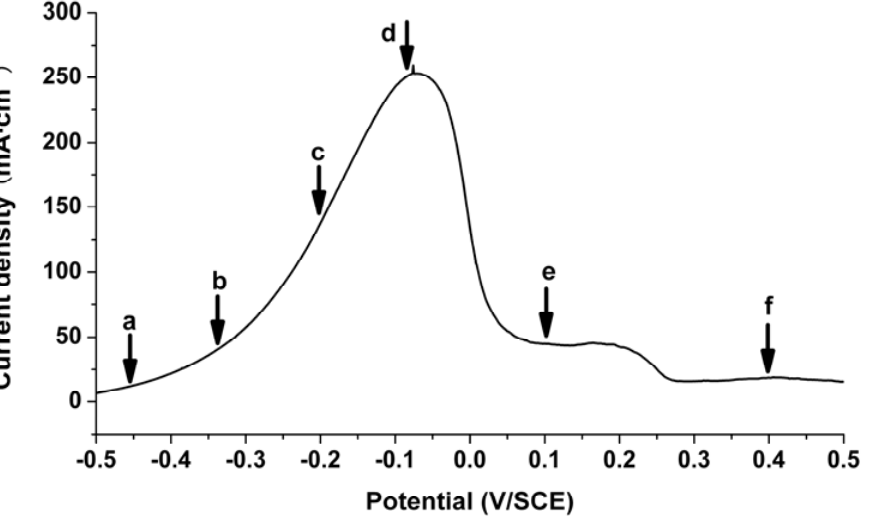
Figure 4. Potentiodynamic polarization curve of the iron electrode in 0.5 M Na solution at 10 mV·s − 1